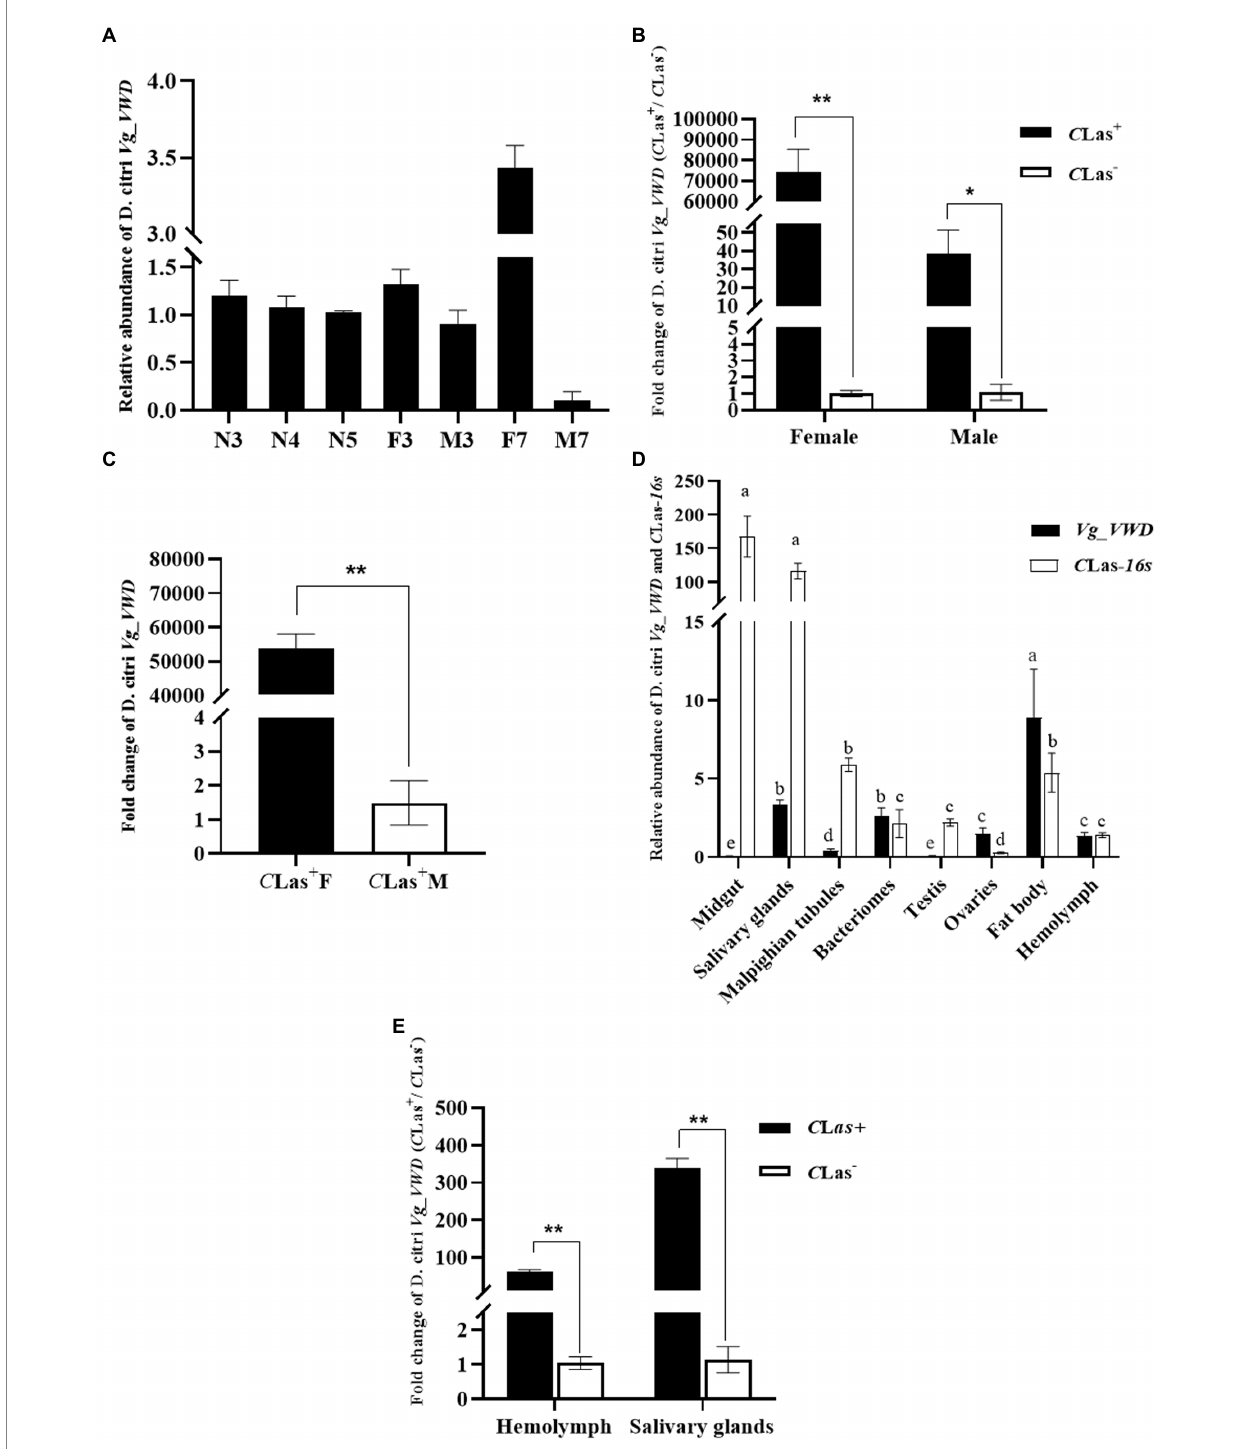
FIGURE 2 Expression profiles of Vg_VWD in different tissues of male and female individuals of D. citri , and sampled at different developmental stages. (A) Relative expression of Vg_VWD at different developmental stages (N3–N5, 3rd- to 5th instar nymphs; 3–7, 3, and 7 days after emergence as adults; F; female, M: male). (B) Relative expression of Vg_VWD between male and female of C Las-infected and uninfected D. citri . (C) Relative expression of Vg_VWD expression between male and female of C Las-infected D. citri . (D) Relative expression of C Las -16 s and Vg_VWD expression in different tissue of C Las- infected D. citri (E) Relative expression of Vg_VWD in the hemolymph and salivary glands of C Las-infected and uninfected D. citri . Data were analyzed using SPSS software, multiple comparisons using the one-way ANOVA followed by least significant difference (LSD) post-hoc tests at a p -value of 0.05. Pairwise comparisons were performed by independent samples t -test. The significant differences are indicated by * ( p < 0.05) or ** ( p < 0.01). Different letters in (E) indicate that the genes in the same middle are different in different types of samples ( p < 0.05), and the gene expression is adjusted by log 10 and then subjected to the one-way ANOVA. GraphPad software was used for